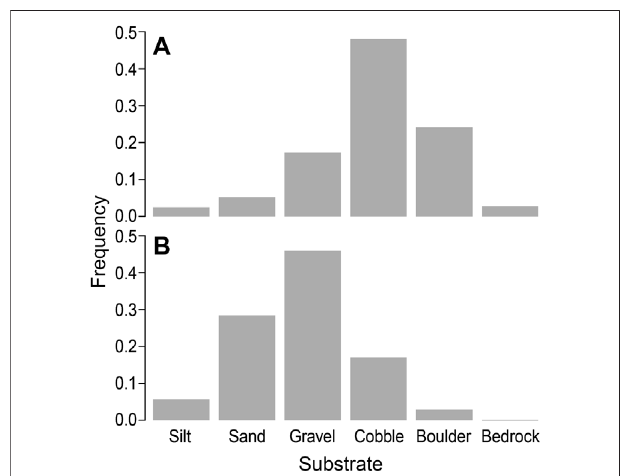
FIGURE 3 | Substrate composition sizes across (A) pre-restoration or unrestored sites compared with (B) post-restorationat four sitesrestored toa Stage 0 condition (Staley Creek, Deer Creek (phase 1), South Fork Mckenzie River (phase 1), Whychus Creek at Camp